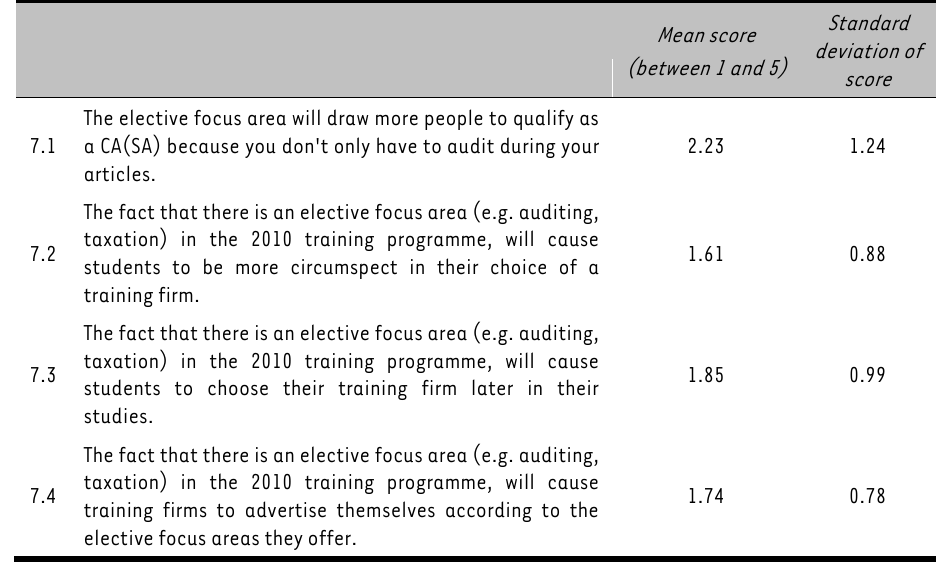
TABLE 7: Perceptions of the effect of the changes